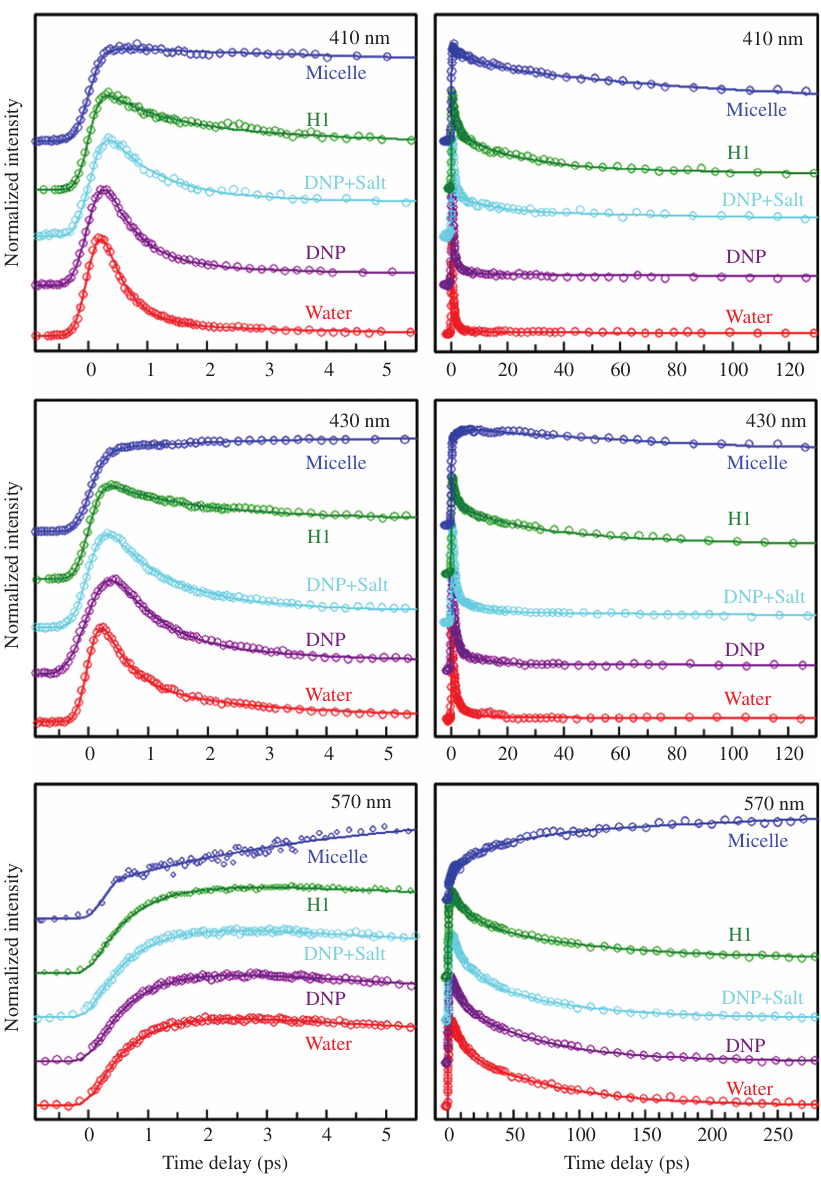
Figure 5 The observed transients of TNS in water, the different biological environments studied, and in cationic micelles. Two time scales are shown, short (left) and long (right), for three typical fluorescent wavelengths: the blue side, emission peak, and the red side. Note the change in time scale for the 570 nm case at long times. All transients are normalized for comparison. [Reprinted with permis- sion from ref. (17) Copyright 2001, Wiley-VCH-Verlag